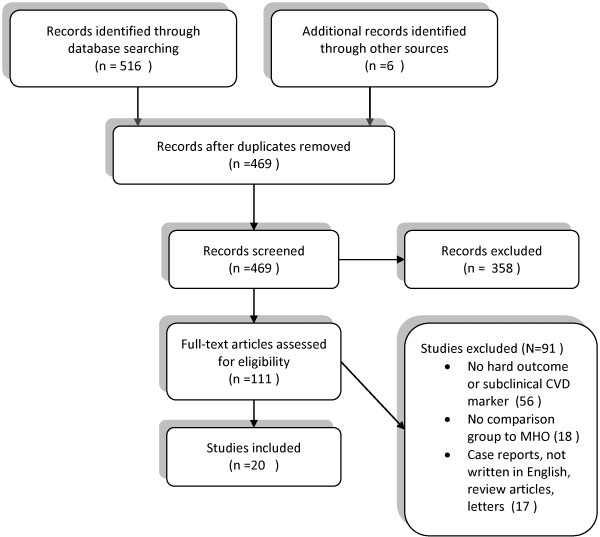
Search flow chart.